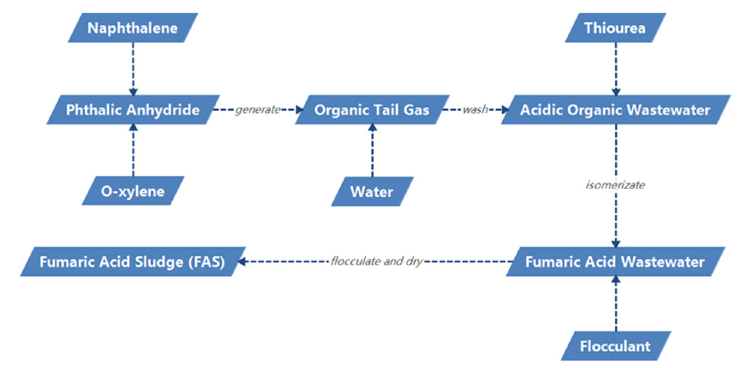
Figure 1. The generated process of fumaric acid sludge (FAS).